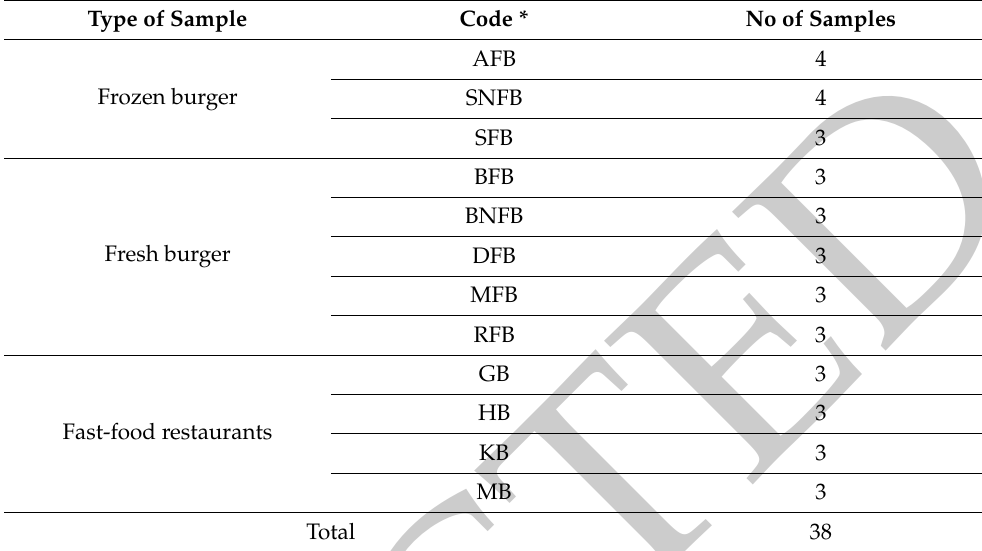
Table 1. Types and outlet distribution of the studied samples. Type of Sample